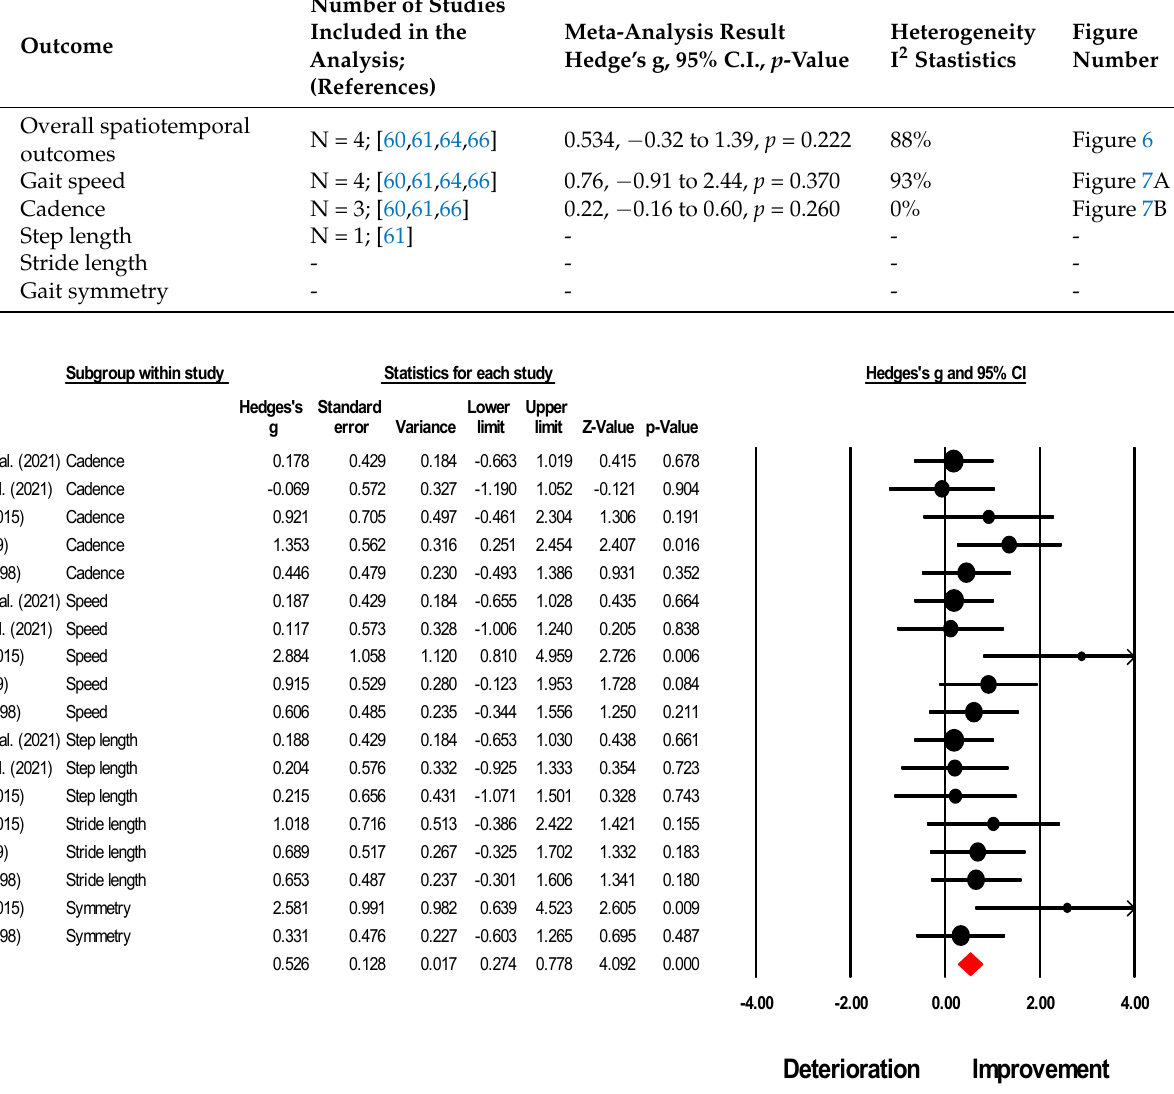
Figure 4. A forest plot depicts the impact of MT on overall spatiotemporal gait outcomes in individuals with TBI. It includes individual weighted effect size Hedge’s g represented as black circles, and the whiskers represent the 95% confidence intervals. The pooled weighted effect size and 95% CI are presented at the bottom with a red diamond. A positive overall effect size in this analysis implies an enhancement in spatiotemporal outcomes of gait with MT, while a negative overall effect indicates a decline in spatiotemporal outcomes of gait with MT. Refs [16,62,63,65,77] mentioned.